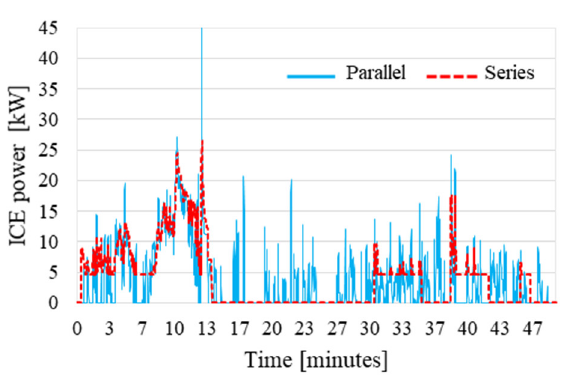
Figure 26. ICE power profile, comparison between parallel and series architectures (Extra-urban).